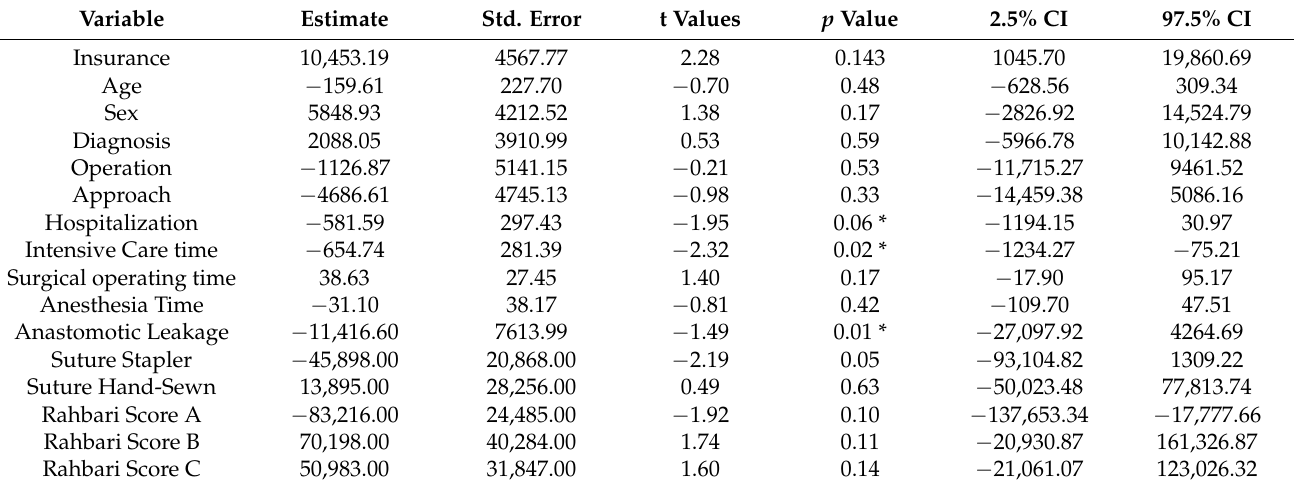
Table 3. Regression model—using the Anova function in R (dependent variable is Net Revenue).